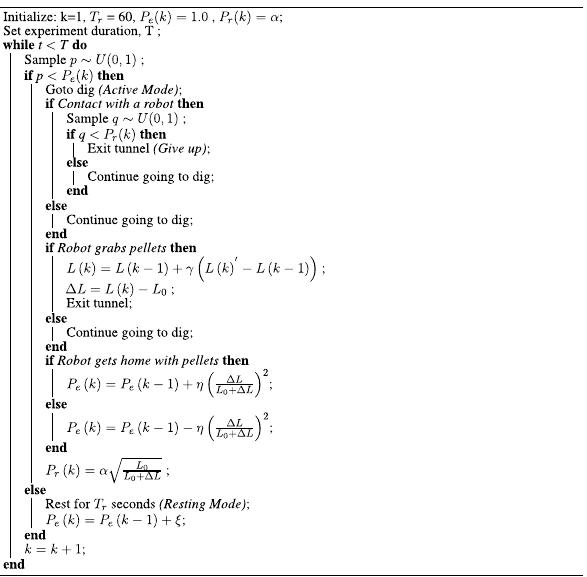
Algorithm 1: Adaptive Learning Rule